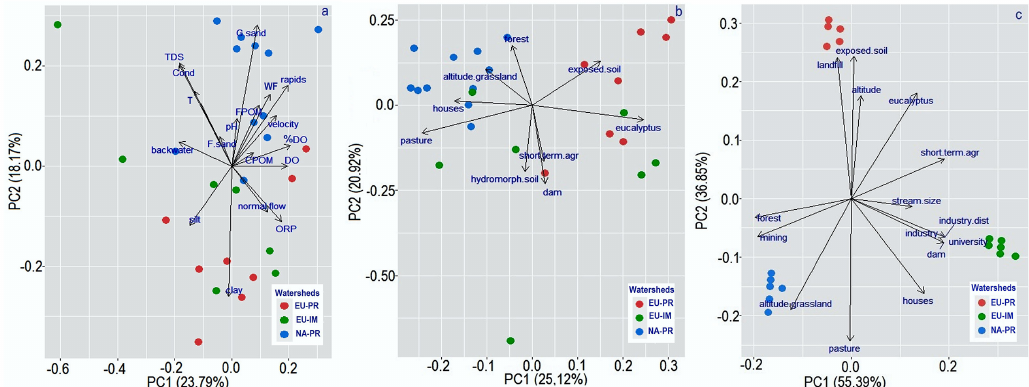
Figure 2. Principal Components Analysis of the local scale of each watershed (a), land uses in the surrounding streams in a buffer of 100 meters radius (riparian scale) (b) and land uses in the watershed as a whole (watershed scale) (c). PC1 = Principal Component 1; PC2 = Principal Component 2; EU-IM = Eucalyptus impacted watershed (without conservation practices); EU-PR = eucalyptus preserved watershed (with conservation practices); NA-PR = native and preserved watershed; CPOM = coarse particulate organic matter; FPOM = fine particulate organic matter; ORP = redox potential; TDS = total dissolved solids; Cond = Electrical Conductivity; WF = Water flow; DO = Dissolved oxygen; %DO = dissolved oxygen percent; T = Water temperature; F.sand = thin sand; G.Sand= course